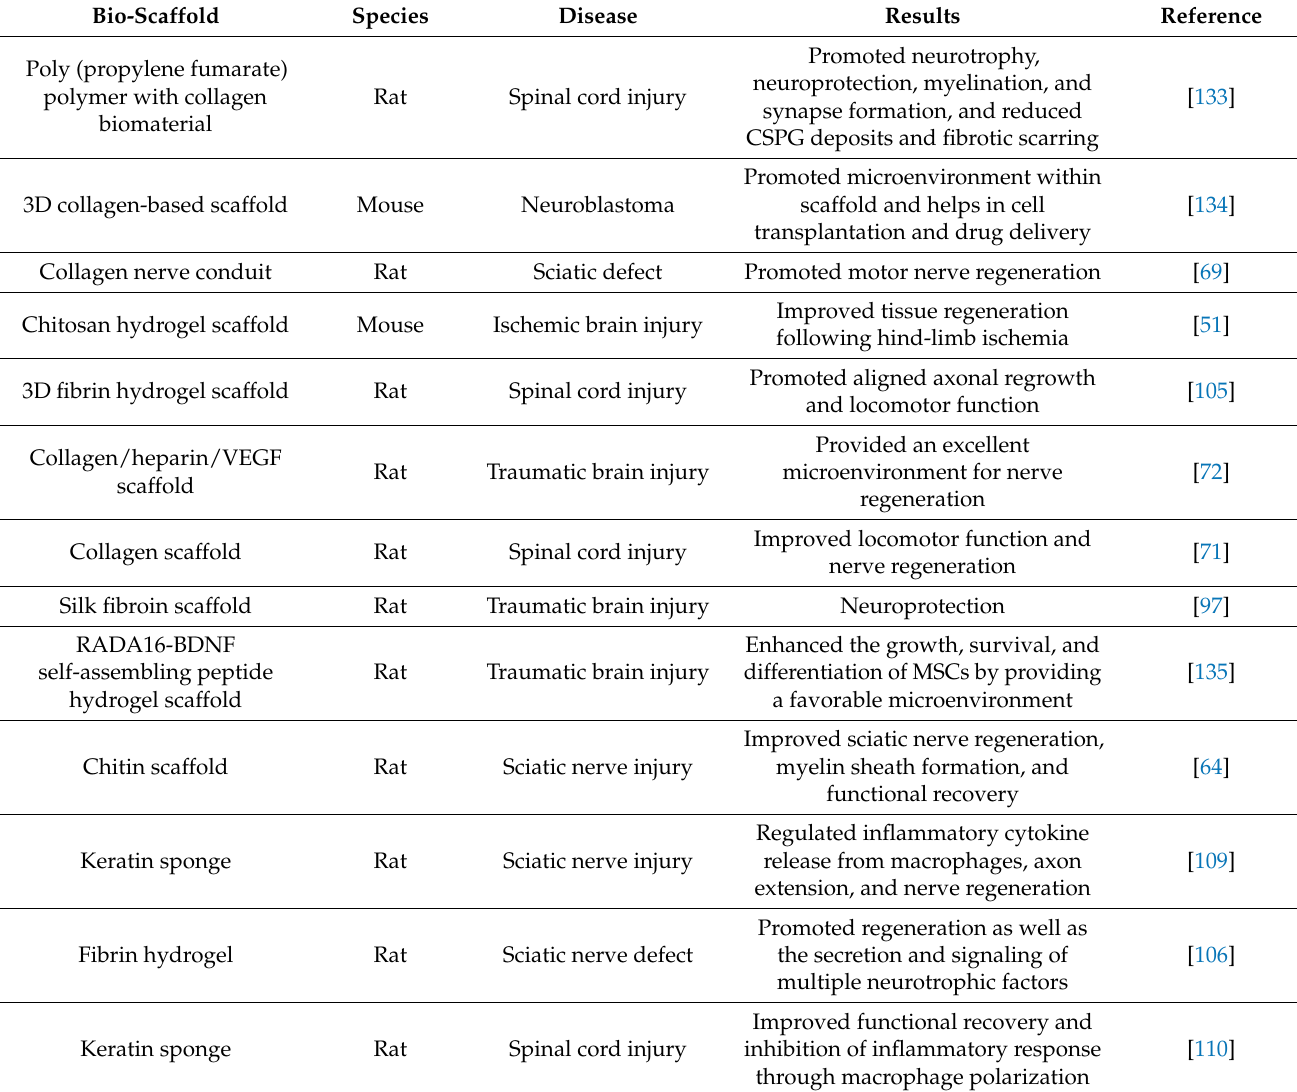
Table 2. Recent studies using bio-scaffolds for nerve injury repair in animal models.